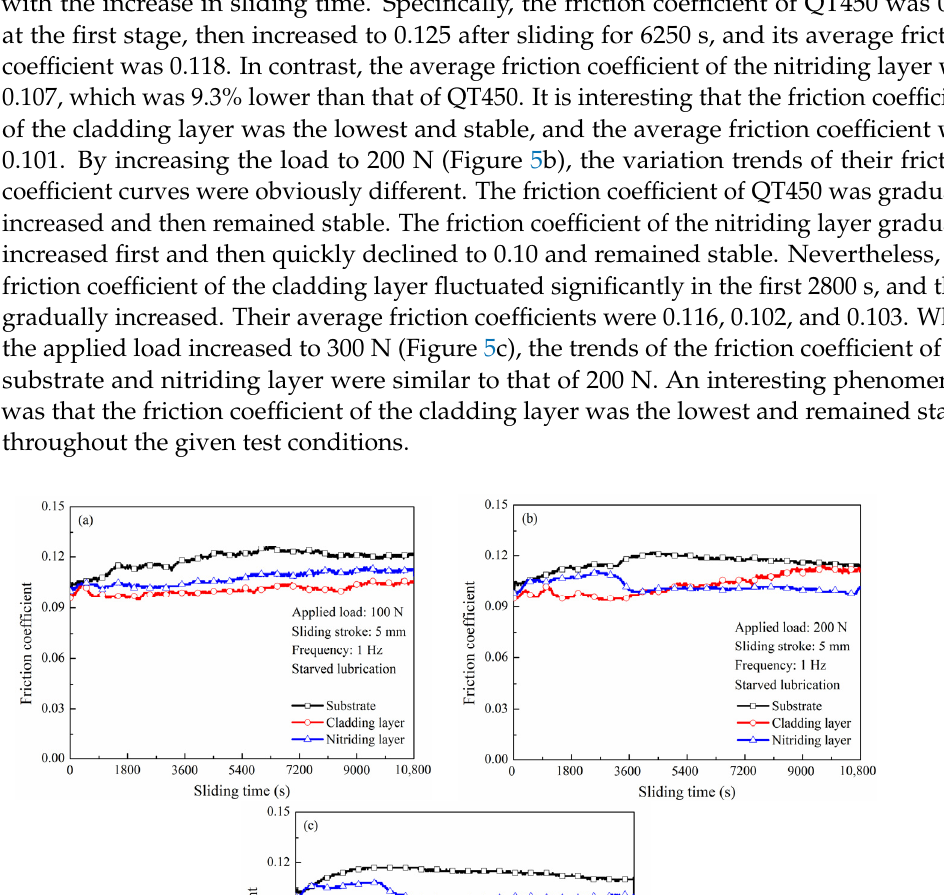
Figure 4. ( a ) Friction coefficient, ( b ) wear depth, and ( c ) wear rates of substrate, cladding layer, and nitriding layer under dry sliding conditions.